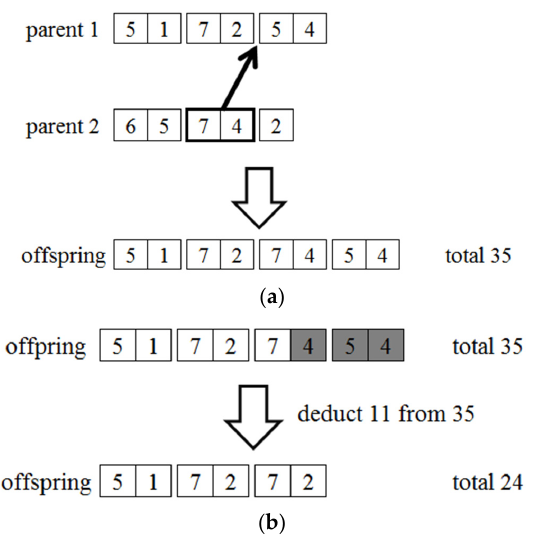
Figure 6. ( a ) Insertion of a pair of slots; and ( b ) trimming values in slots to make the sum 24. Mutation Operation